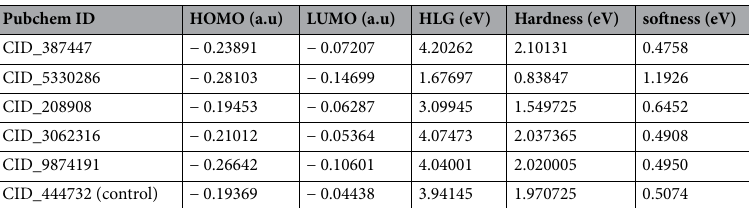
Table 1. DFT calculation of the selected compounds after molecular and MM-GBSA